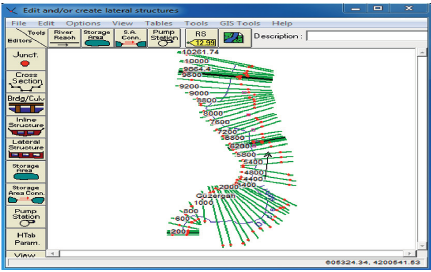
Figure 5: Cross sections of the